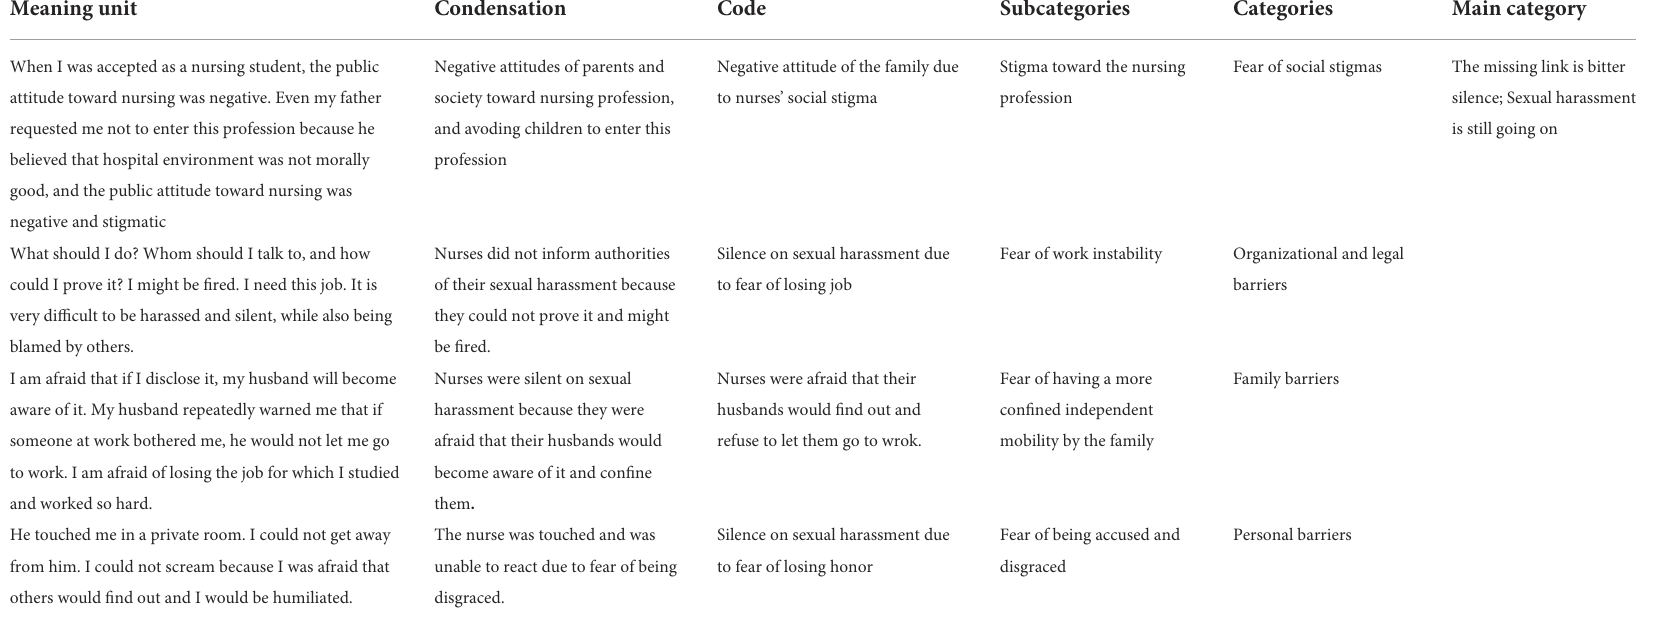
TABLE 3 Example of qualitative content analysis process. Meaning unit